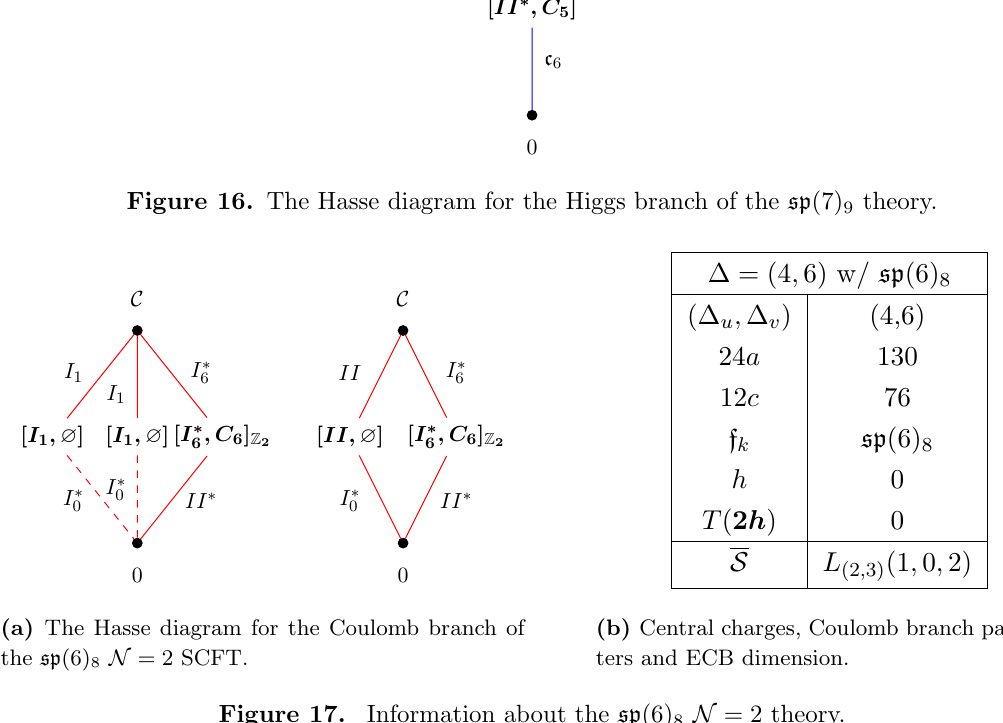
Figure 17. Information about the sp (6) 8 N = 2